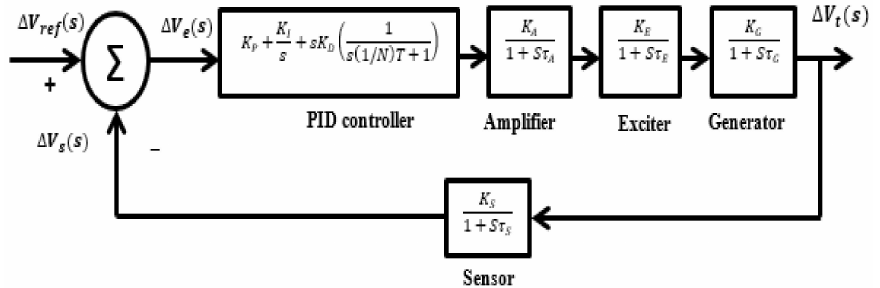
Figure 14. Transfer function block diagram of the proposed system “Adapted with permission from